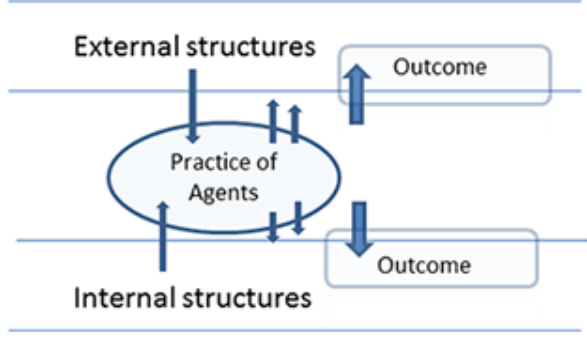
Fig. 1. Illustration of a conceptual model of the